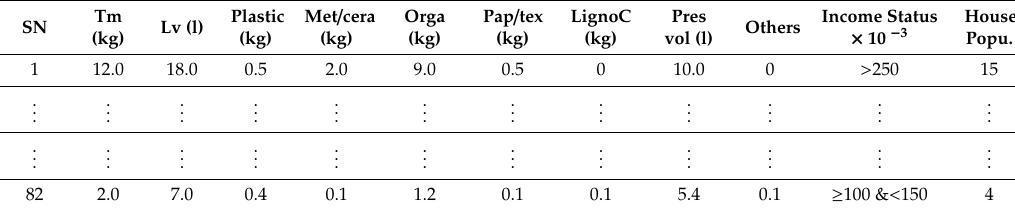
Table 2. The structure of the logging table for waste